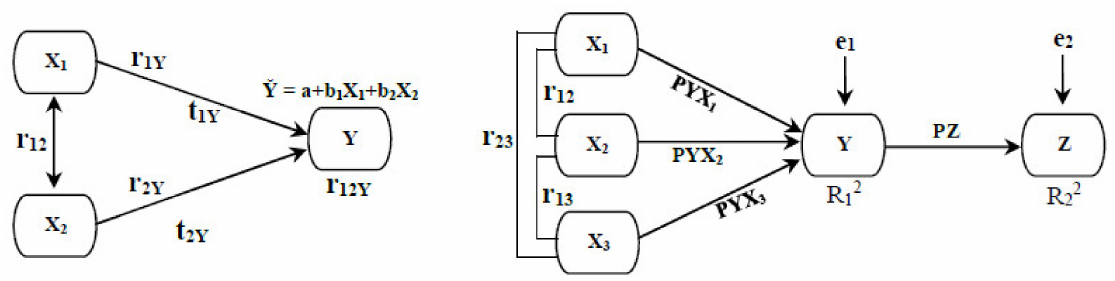
Figure 4. Model of multiple regression analysis and path